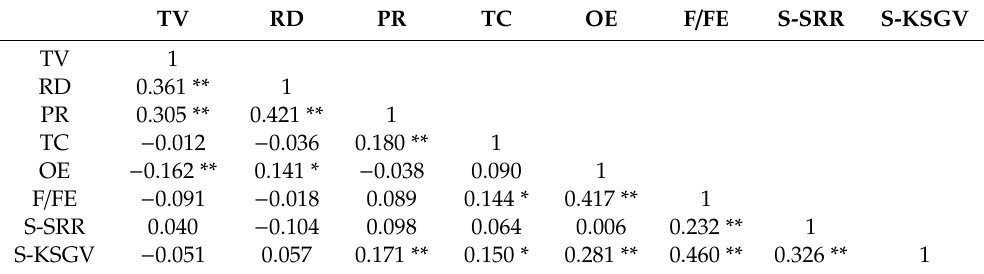
Table 2. Bivariate correlations between knowledge of situations of violence, sources of information, and situations of risk in a